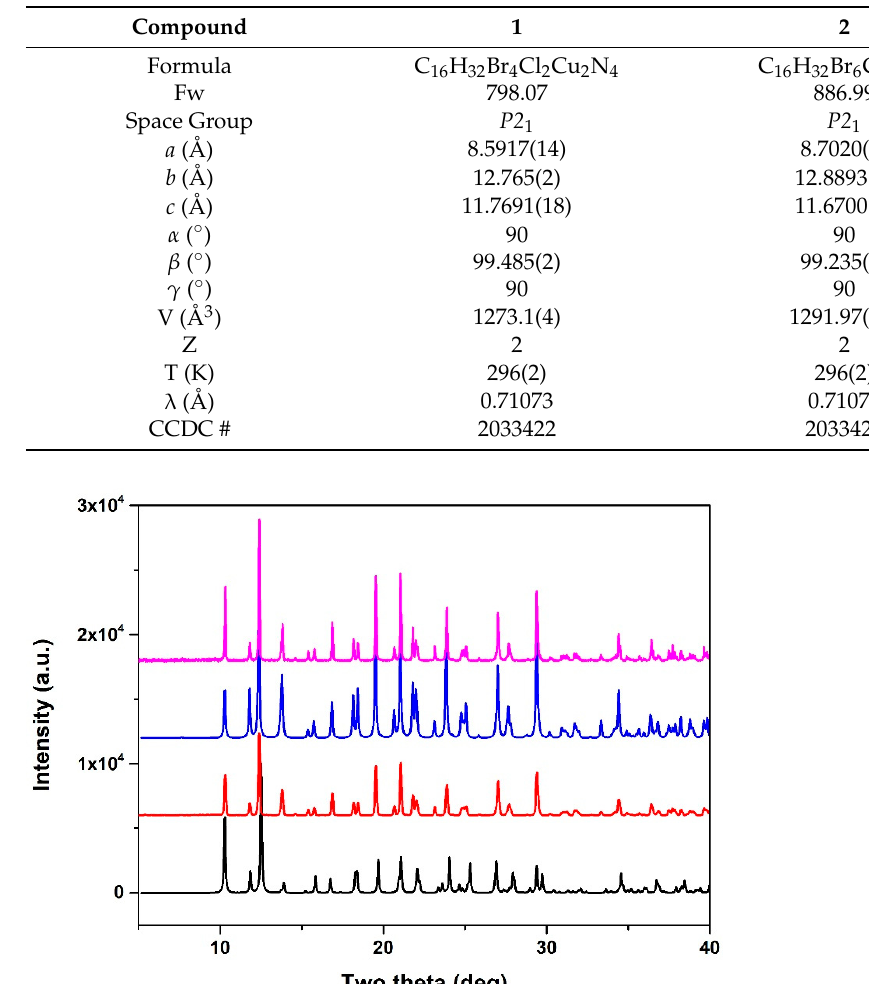
Figure 4. PXRD patterns 1 – 2 . From bottom to top: simulated 1 , as made 1 , simulated 2 , as made 2 .